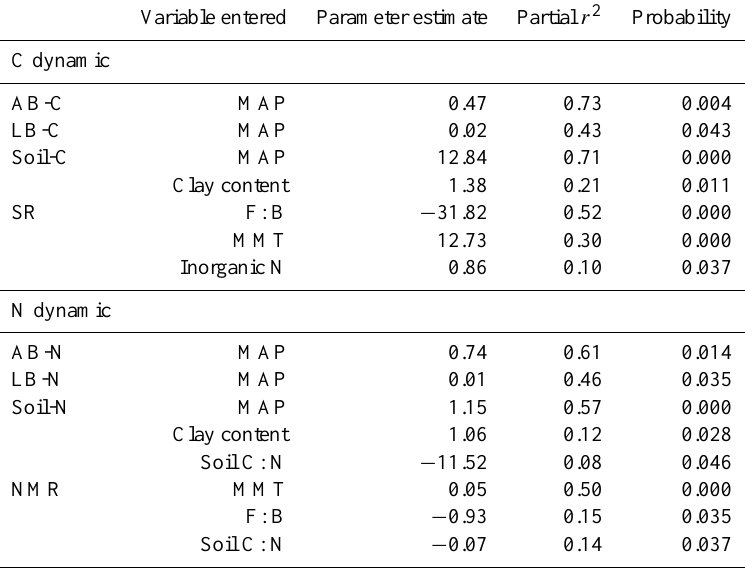
Table 2. Results of stepwise multiple regression analyses. Dependent variables: aboveground biomass C (AB-C,gm − 2 ) , litter biomass C (LB-C,gm − 2 ) , soil C (gm − 2 ) , soil respiration (SR, mgkg − 1 d − 1 ) , aboveground biomass N (AB-N,gm − 2 ) , litter biomass N (LB- N,gm − 2 ) , soil N (gm − 2 ) , net N mineralization (NMR, mgkg − 1 d − 1 ) ; independent variable: mean annual precipitation (MAP,mm), soil clay content (%), soil fungal:bacterial biomass (F : B), mean monthly temperature (MMT, ◦ C), soil inorganic N (mgkg − 1 ) , soil C : N. Neg- ative values of parameter estimates refer to negative relationships between the examined dependent variables and the independent variables. Variable entered Parameter estimate Partial r 2 Probability C dynamic AB-C